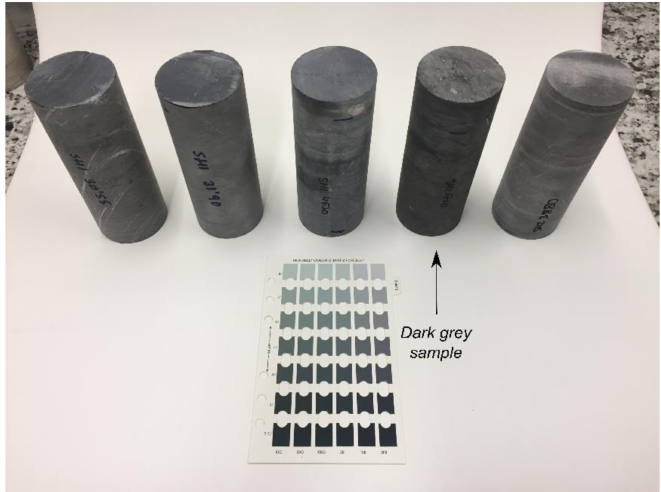
Figure 2. Changes in the grey tone and very thin veins of calcite observed in the intact samples. A dark grey texture was separated from the rest of samples and does not form part of this